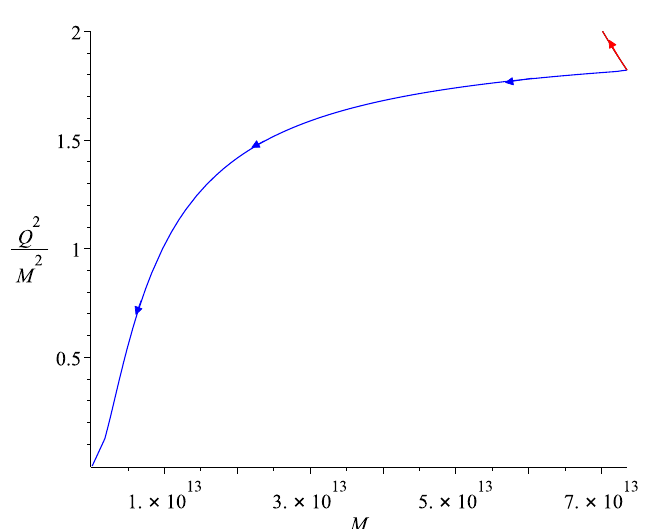
Figure 5 . GHS black hole evolution with initial conditions M (0) = 7 : 35 (cid:2) 10 13 and Q (0) = 1 : 35 M (0). The curves, from top to bottom (red, black, blue), correspond to the choice C = 0 ; 1 ; 2, respectively, in the charge loss formula eq. (4.1). The top two curves essentially overlap in this plot. Arrows denote the direction of evolution.